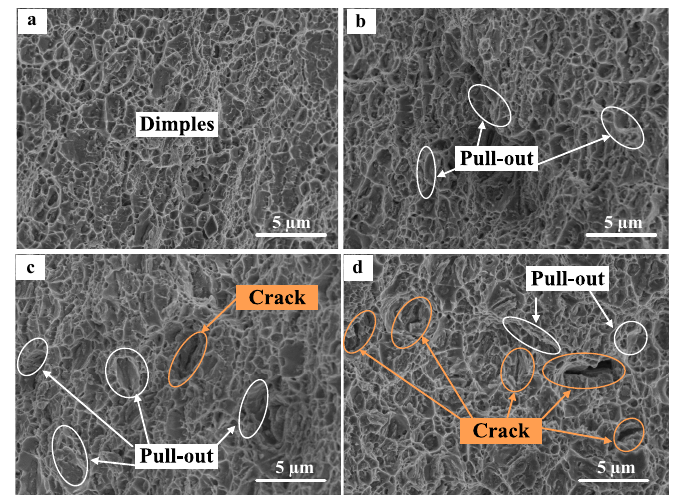
Figure 13. Tensile fracture morphologies of ( a ) 7075 Al; ( b ) 0.15 rGO/7075 Al; ( c ) 0.30 rGO/7075 Al; and ( d ) 0.50 rGO/7075 Al.